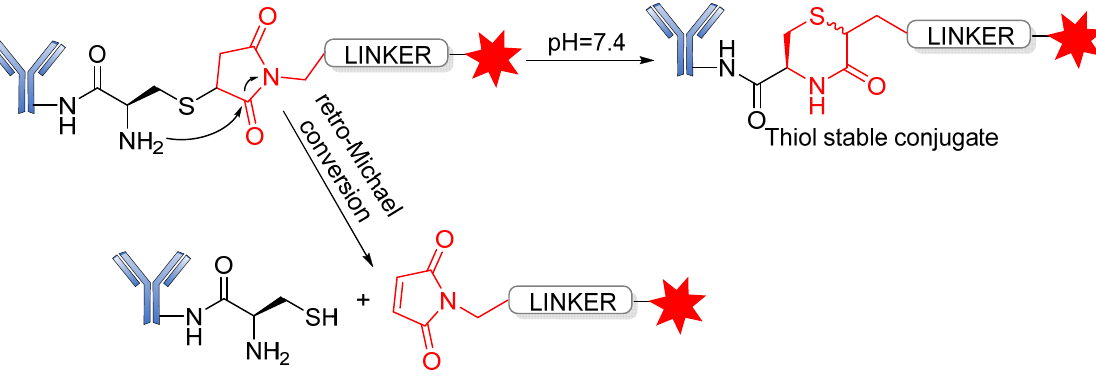
Table 2. Antibody-drug conjugates approved.